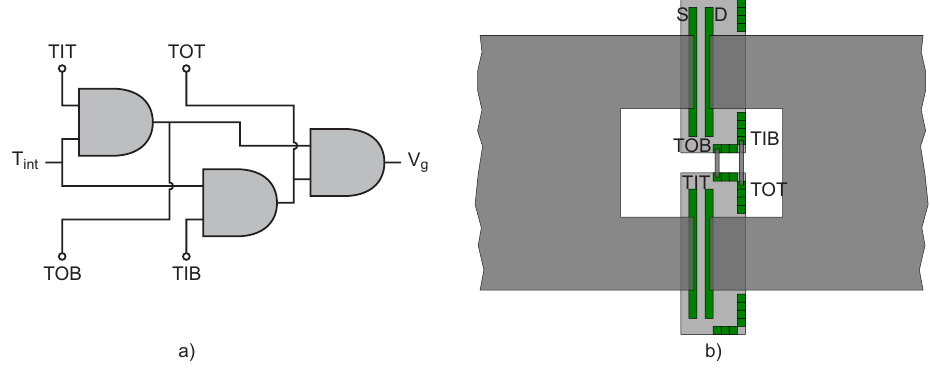
Figure 9. Synchronization circuit: ( a ) schematic and ( b ) chip